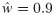
Amplifying the redistribution of inhibition along PCs by the SOM-VIP motif.(A) Connectivity of the circuit model, inspired by experimentally observed connectivity of excitatory pyramidal cells (PCs) and inhibitory PV, SOM and VIP neurons (see main text). VIP neurons receive an additional, modulatory input. (B) Population rates of all neuron types as a function of the modulatory input onto VIP cells. The PC rate follows a sigmoid function, the slope of which characterizes the gain of the redistribution of somato-dendritic inhibition upon a change in the modulatory input. (C) Reference network without VIP neurons, in which modulatory input targets SOM neurons instead (with inverted sign for comparability). (D) The firing rate curve of the PCs in the full network (A) exhibit a larger slope than in the reference network without VIP neurons (C). Reference curve shifted for comparability. (E) Reduced network of inhibitory PV, SOM and VIP neurons (left) that allows a mathematical analysis, and a corresponding reference network without VIP neurons (right). (F) The difference of PV and SOM neuron rates (somatic and dendritic inhibition, respectively) follows a sigmoid function. In the full interneuron network (E, left), it exhibits a larger slope than a corresponding reference network without VIP neurons (E, right) (mutual inhibition strength w^=0.9). (G) Amplification index depends strongly on the mutual inhibition strength. Positive values denote an amplification, negative values indicate an attenuation. An infinitely large amplification index corresponds to a winner-take-all (WTA) regime. When the connections from SOM to VIP neurons are knocked-out (red), the amplification index rises slowly—logarithmically with the connection from VIP to SOM neurons—and reaches the amplification regime for much larger connection strengths. Parameters (A-D): Mutual inhibition strength w^=0.7, adaptation strength b = 0.2, initial synaptic efficacy Us = 0.4.